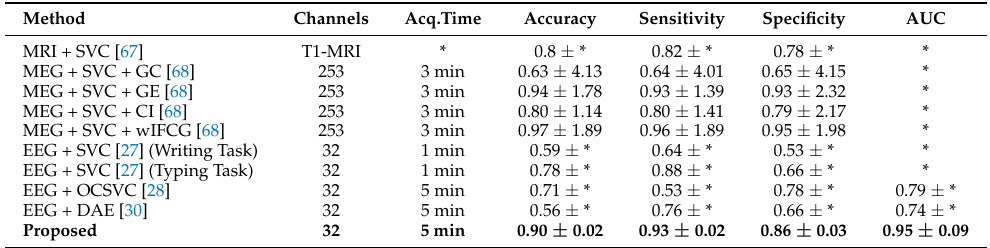
Table 3. Classification results for various studies related to dyslexia classification. Standard deviation is indicated in each case. (*) data not reported in the